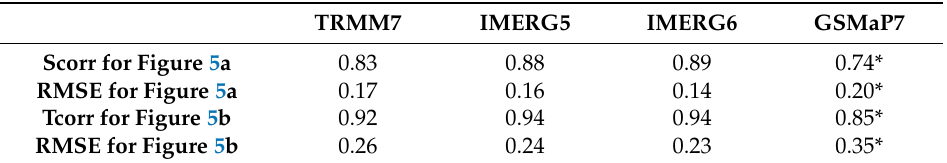
Table 2. Statistical values for the comparison between the CWB data and SPPs shown in Figure 5. The unit of RMSE is mm · d − 1 . The lowest value of Scorr and Tcorr, as well as the highest value of RMSE, are marked by *. The sample size of spatial variation is 392 grid points. The sample size of temporal variation is 24 hours.